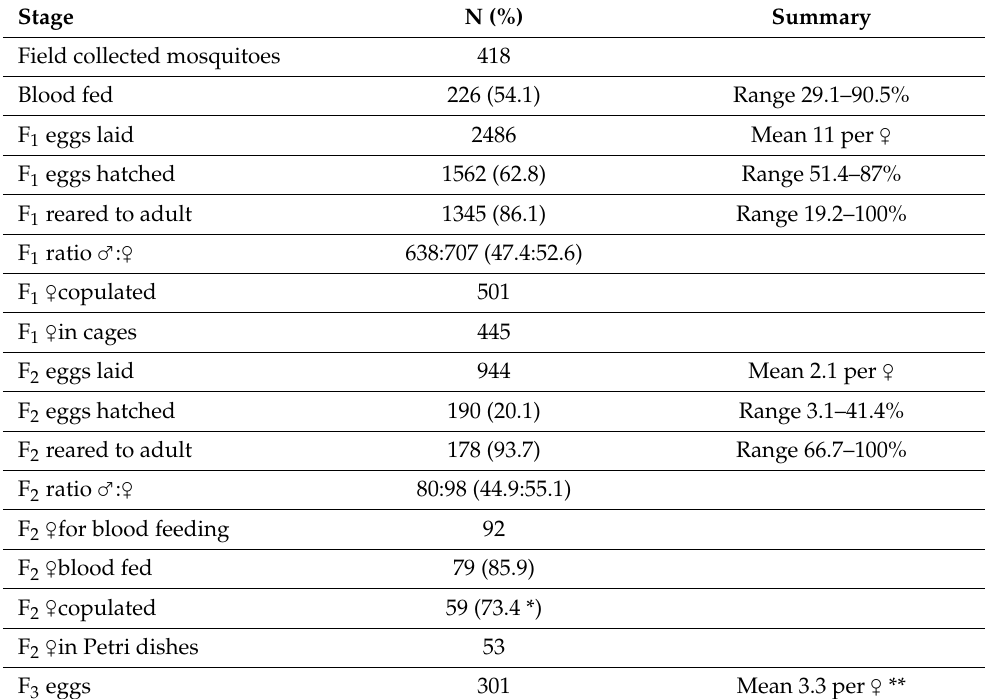
Table 1. Summary table showing progression from field collected mosquitoes through to F 3 eggs for all mosquitoes included in the